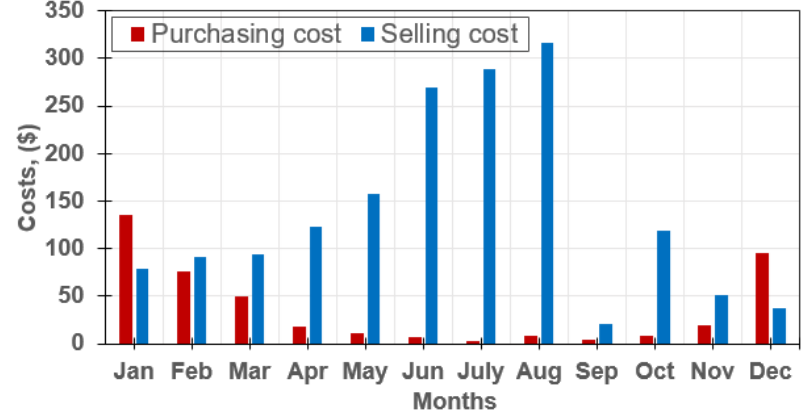
Figure 9. Monthly electricity bills, M(t).